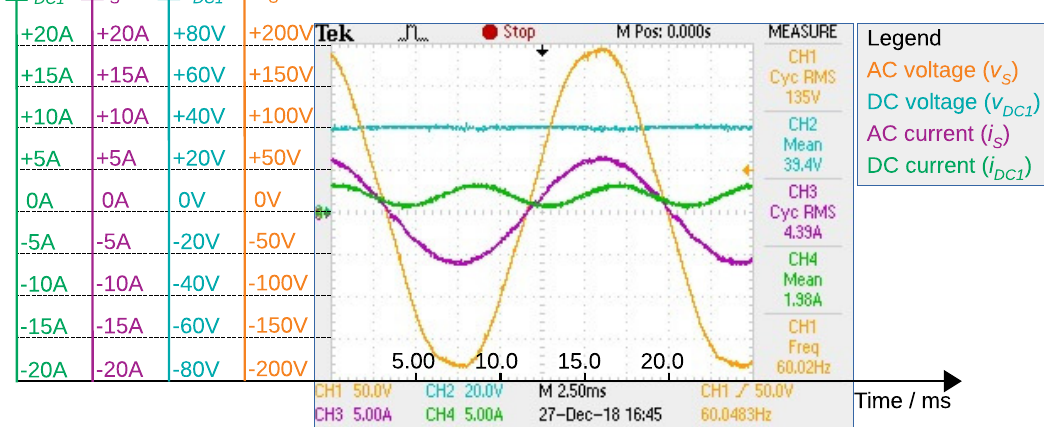
Figure 13. Measurements at 16:45 (of day 1)—Converter injecting active power (medium) on the